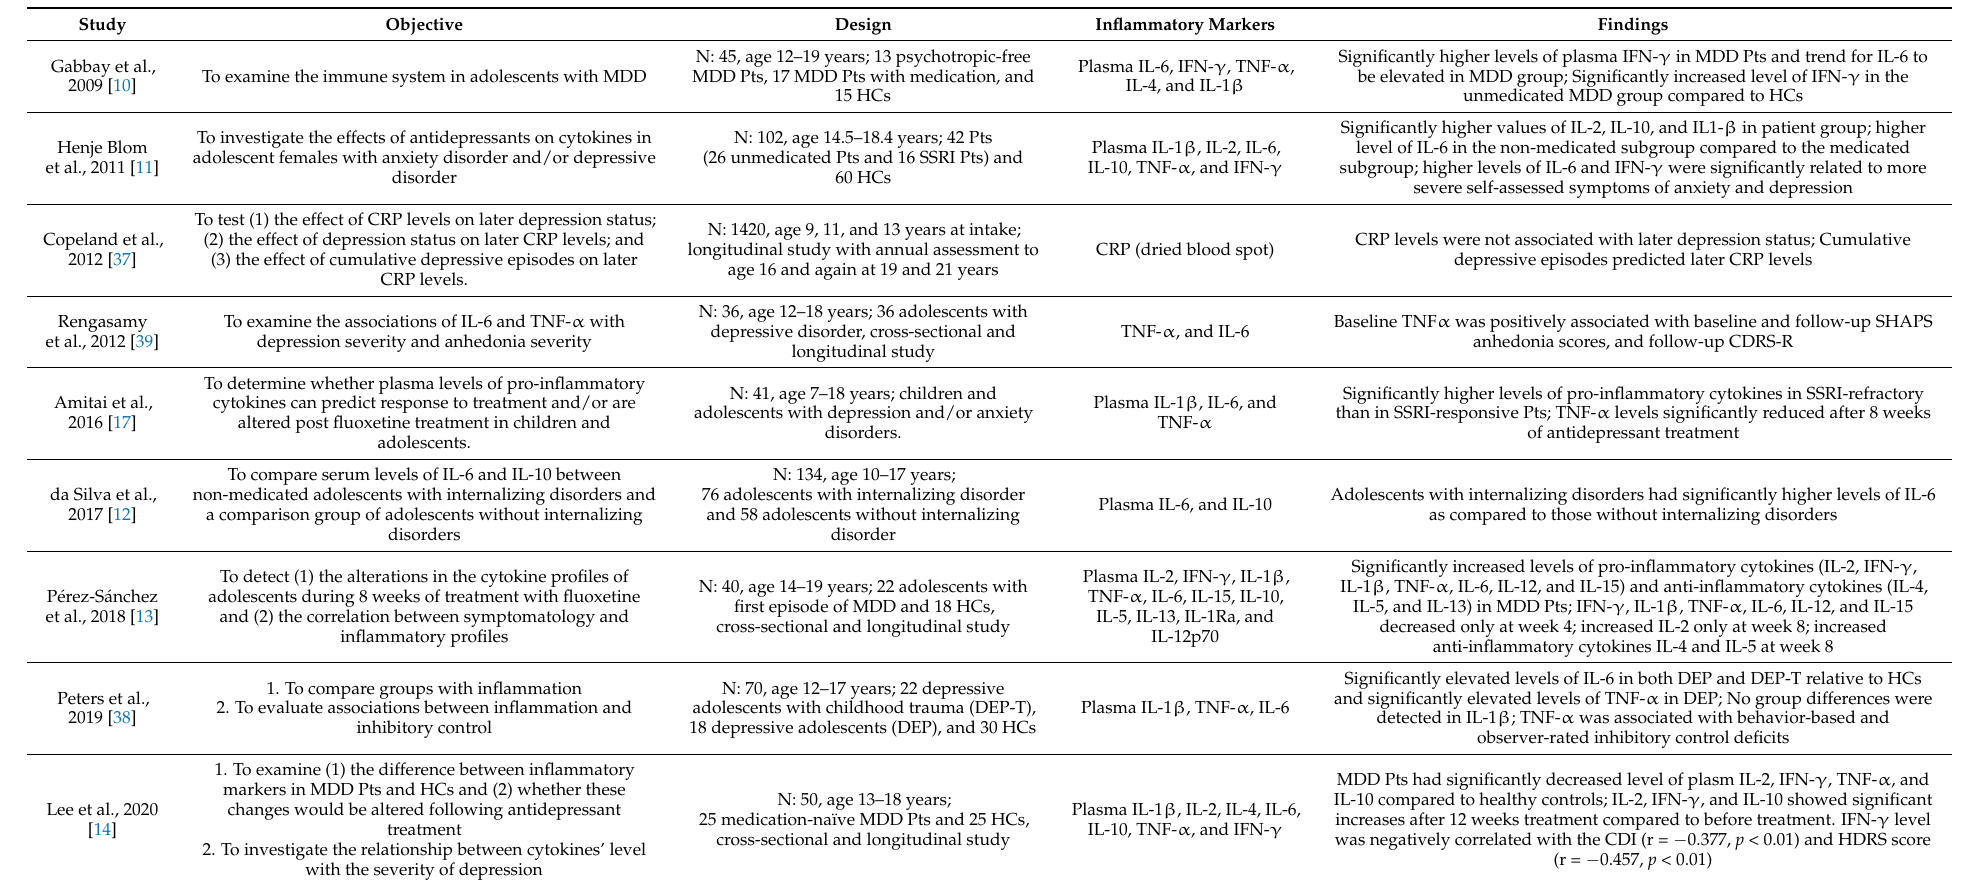
Table 1. Previous studies of cytokines in pediatric depressive